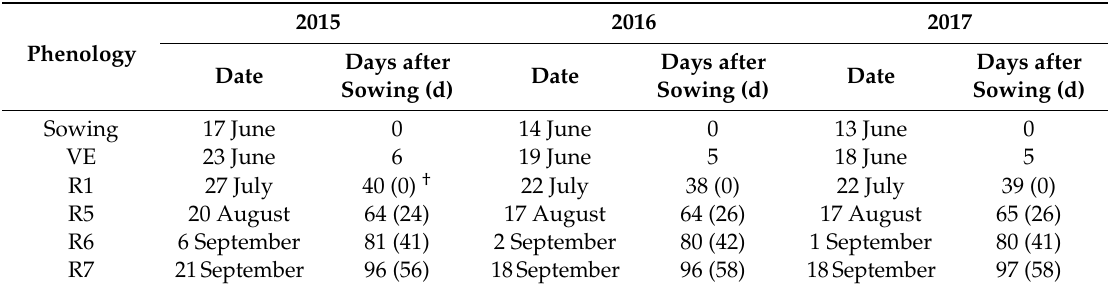
Table 2. The growth stages of soybean cultivars under the di ff erent planting patterns in 2015–2017.